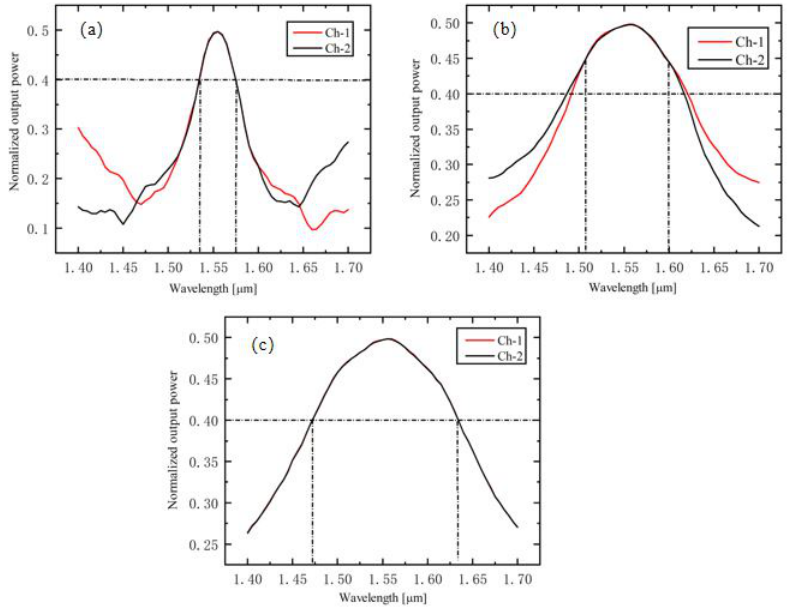
Figure 9. Simulated output power of the ( a ) general, ( b ) paired, and ( c ) symmetric 1 × 2 beam splitter across the